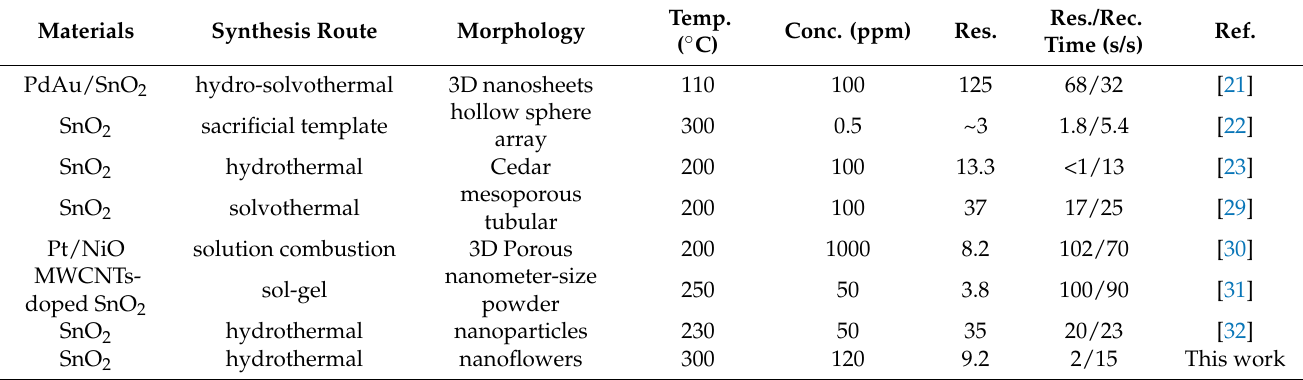
Table 1. HCHO sensing performance of different